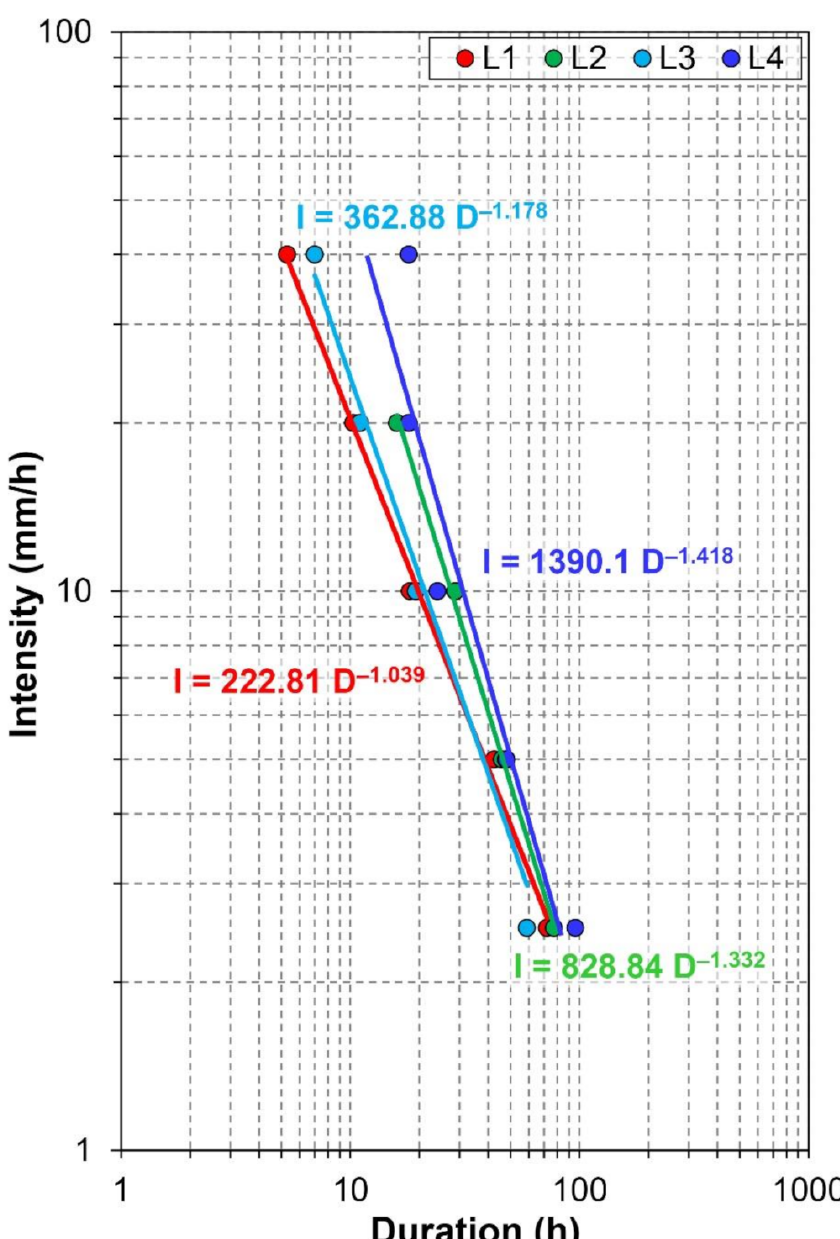
Figure 7. Comparison between deterministic rainfall thresholds obtained by TRIGRS (L4 site) and those obtained by coupled hydrological and stability modelling [77] of representative slopes (L1, L2 and L3